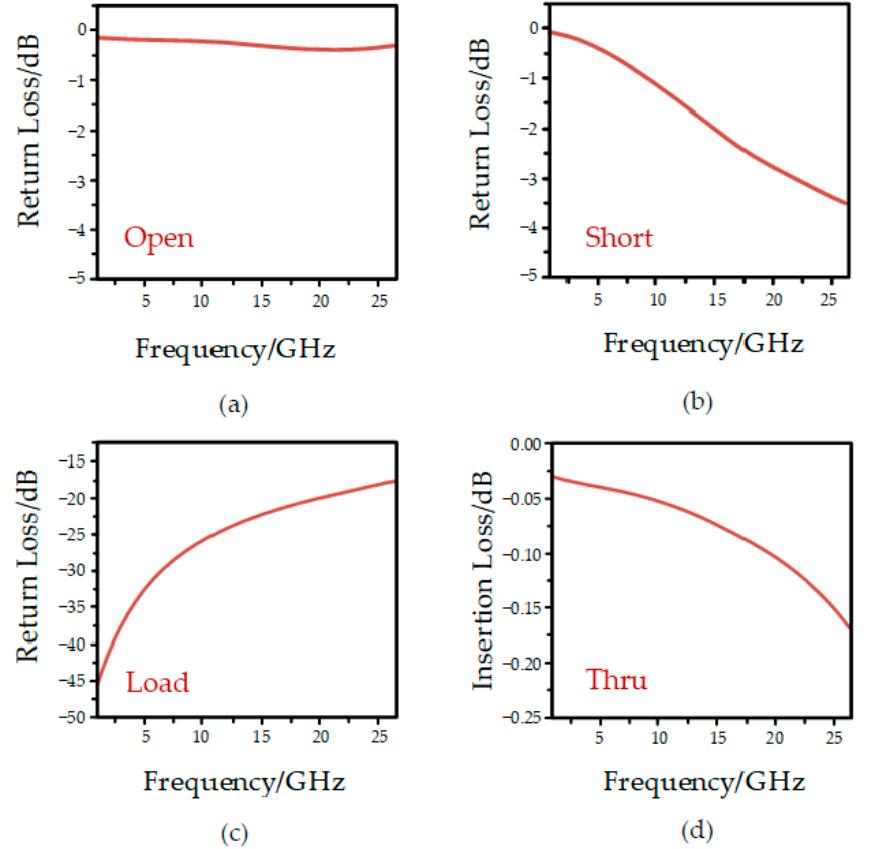
Figure 2. Simulation results in different states: ( a ) Open circuit; ( b ) short circuit; ( c ) load circuit; ( d ) Thru